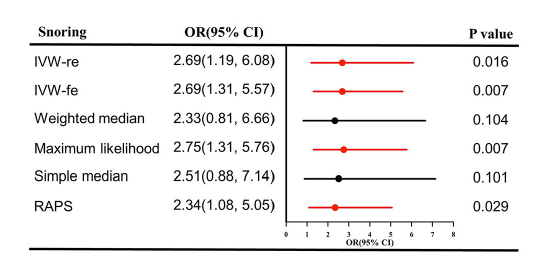
FIGURE1 Causal effect estimates of snoring on stroke in SVMR. OR, odds ratio; CI, confidence interval; IVW, inverse variance weighted method; RAPS, robust adjusted profile score; MR, Mendelian randomization; SVMR, single-variable Mendelian